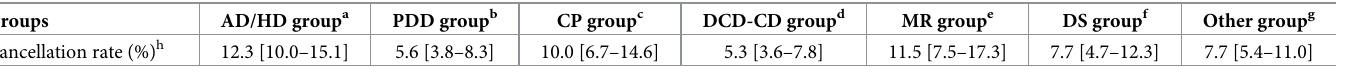
Table 2. Cancellation rates in each diagnostic group.